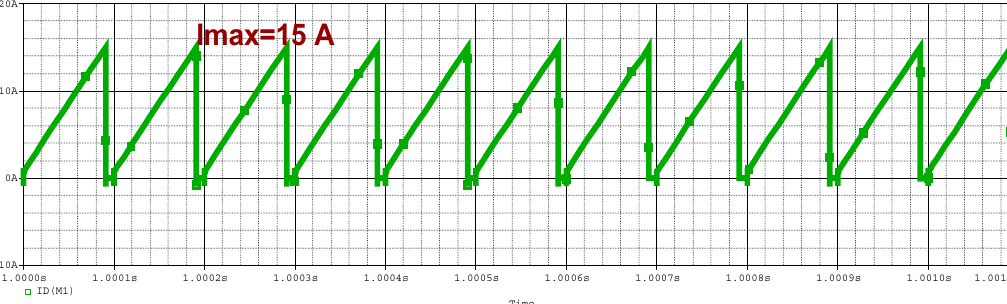
Figure 34. Current through switch “s” of the bidirectional CUK converter for a 400-V output [33].